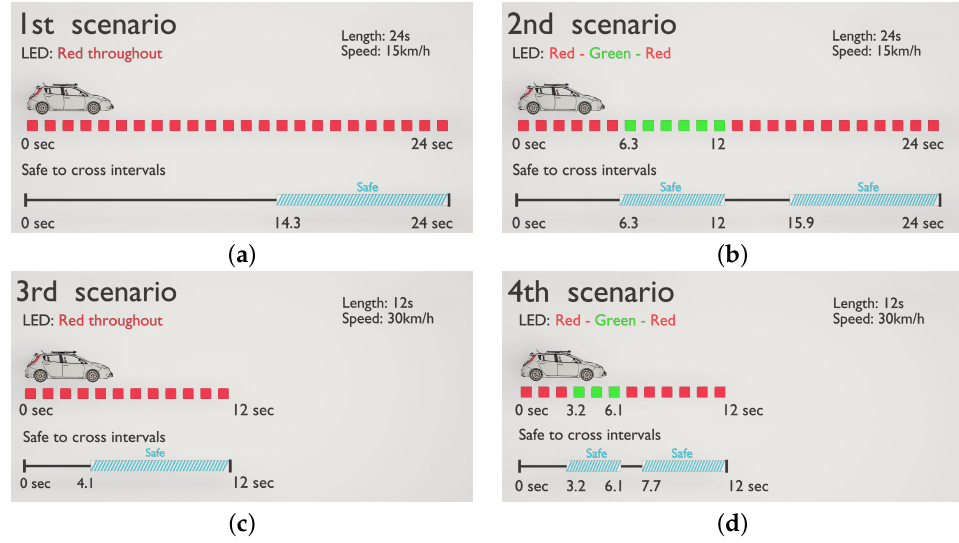
Figure 2. Scenarios: ( a ) Scenario 1, ( b ) Scenario 2, ( c ) Scenario 3, ( d ) Scenario